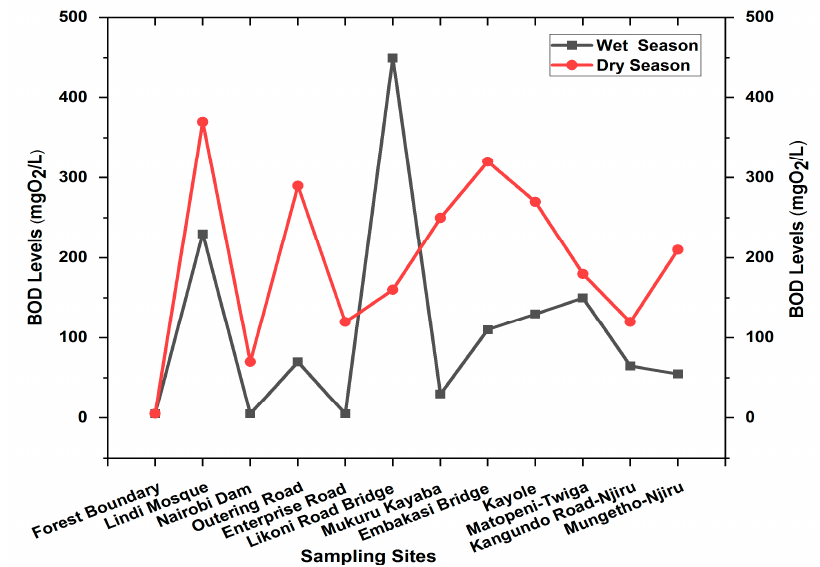
Figure 2. BOD levels for Ngong River for wet and dry season measured in April and August,